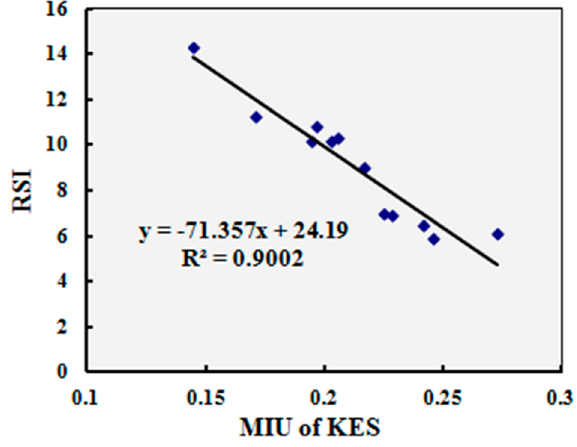
Figure 13. Relationship between relative smoothness index (RSI) and MIU of the KES system, MIU: mean friction coefficient.